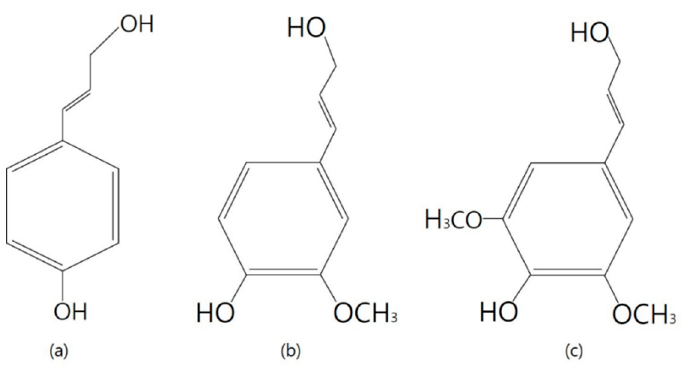
Figure 2. Chemical structure of lignin precursor; ( a ) p-coumaryl alcohol (H), ( b ) coniferyl alcohol (G), and ( c ) sinapyl alcohol.